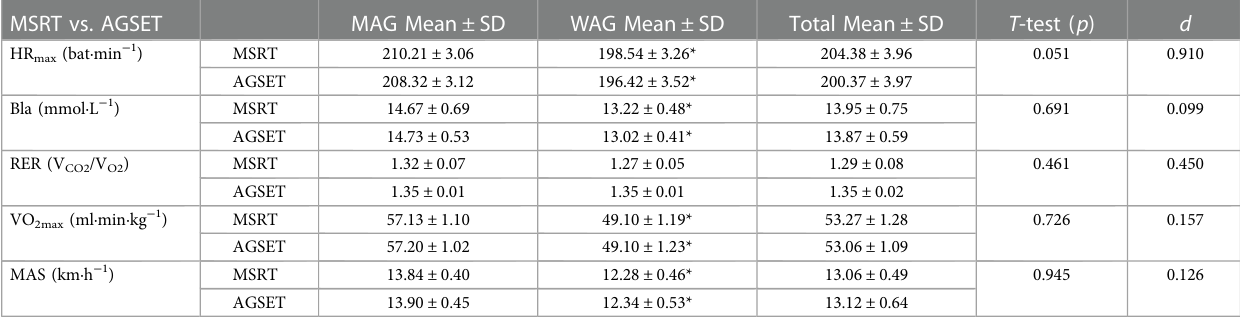
(MAG) Men ’ s artistic gymnastics; (WAG) Women ’ s artistic gymnastics; (MSRT) multistage shuttle run test; (AGSET) artistic gymnastics speci fi c endurance test; (MAS) maximal aerobic speed; (BLa) blood lactate; (HR) heart rate; (RER) respiratory exchange ratio. *Signi fi cantly different from MAG.